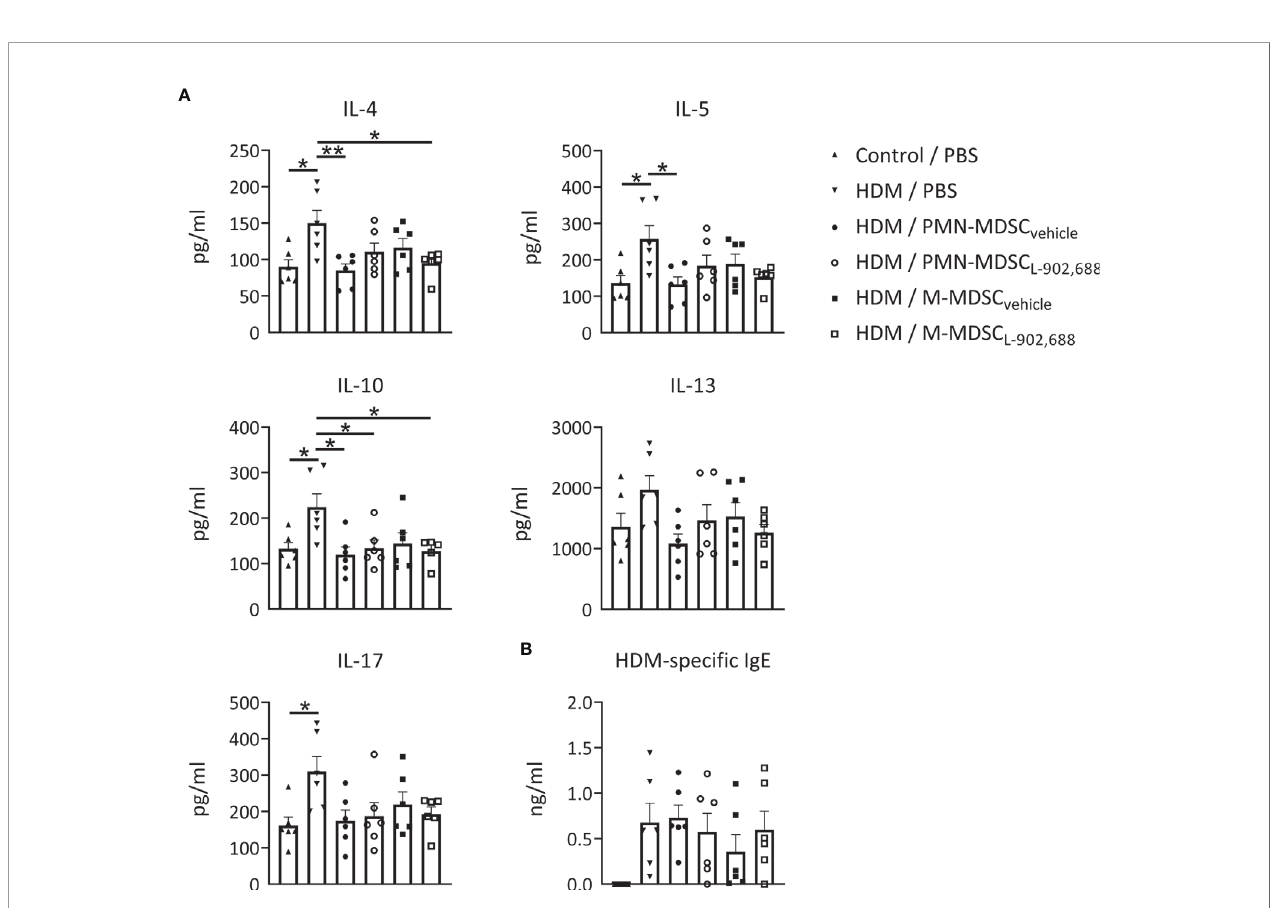
FIGURE 4 | The effect of adoptively transferred MDSC L-902,688 on pro-in fl ammatory cytokine and IgE production in a murine model of asthma. 6- to 8-week-old female BALB/c mice were exposed to HDM or PBS on days 0, 7, 8, 9, 10 and 11. Bone marrow cells from hind legs of naïve female BALB/c donor mice were cultured in the presence of the EP4 agonist L-902,688 (10 µM) or vehicle in combination with GM-CSF (20 ng/ml) and IL-6 (20 ng/ml) for three days. Cultured PMN- and M-MDSCs were isolated and adoptively transferred (2x10 6 of either PMN- or M-MDSCs) to the host mice on day 7 after HDM sensitization. Three days after the last HDM exposure (A) BAL supernatants were collected and examined for IL-4, IL-5, IL-10, IL-13, and IL-17A/F, and (B) serum supernatants were collected and examined for HDM-speci fi c IgE levels using ELISAs. Data was obtained from 6 independent experiments with 2 technical replicates per experiment. Results of individual experiments and mean ± SEM are shown. Statistical analysis was performed with one-way ANOVA followed by Tukey ’ s multiple comparisons test. * p < 0.05, ** p <